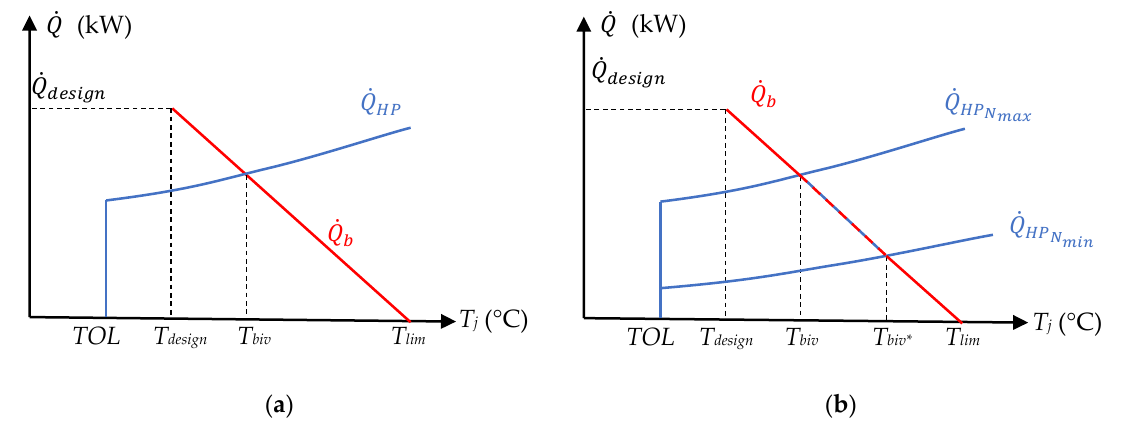
Figure 1. Typical evolution of the building heating load and heat output curve of a heat pump as a function of the outdoor temperature for ( a ) a heat pump with a fixed speed compressor and ( b ) a heat pump with a variable speed compressor.